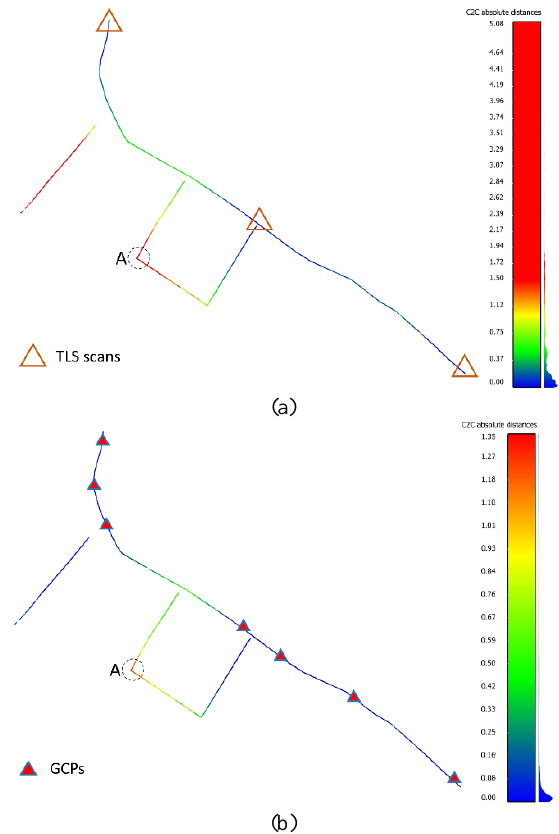
Figure 11. C2C distance along the Z direction (a) between the point cloud derived from the GCSs method and the photogrammetric point cloud and (b) between the point cloud derived from the GCPs method and the photogrammetric point cloud. Unit of measure: metre. Finally, a more systematic analysis involving Corso Matteotti is performed and reported in Table 4. The analysis regards the GCPs and GCSs methods and the point cloud processed without using any constraints. Punctual comparison of the